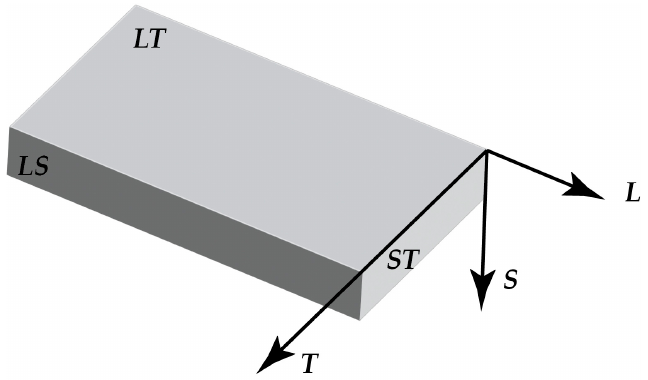
Figure 1. Schematic representation of plane and direction designation of sheet material.